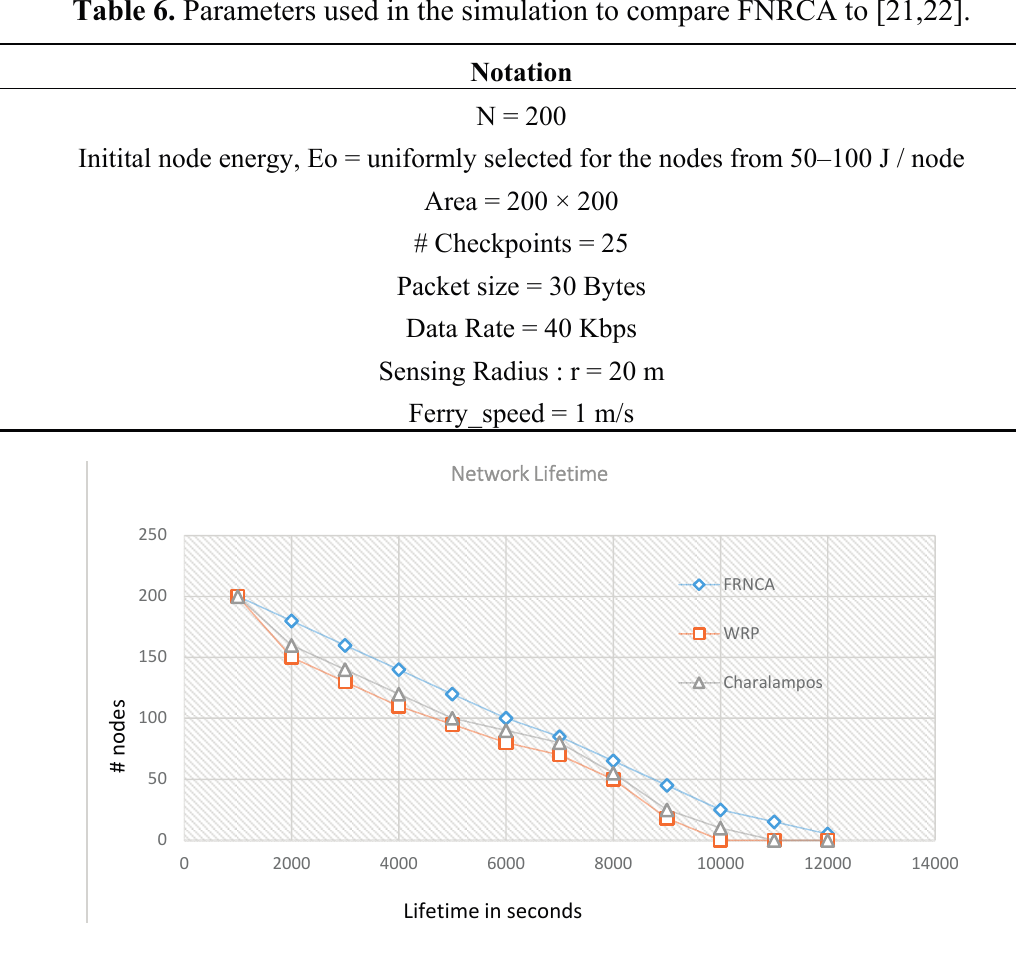
Figure 5. Network Lifetime for FNRCA, WRP and Charalampos using different initial energy values.